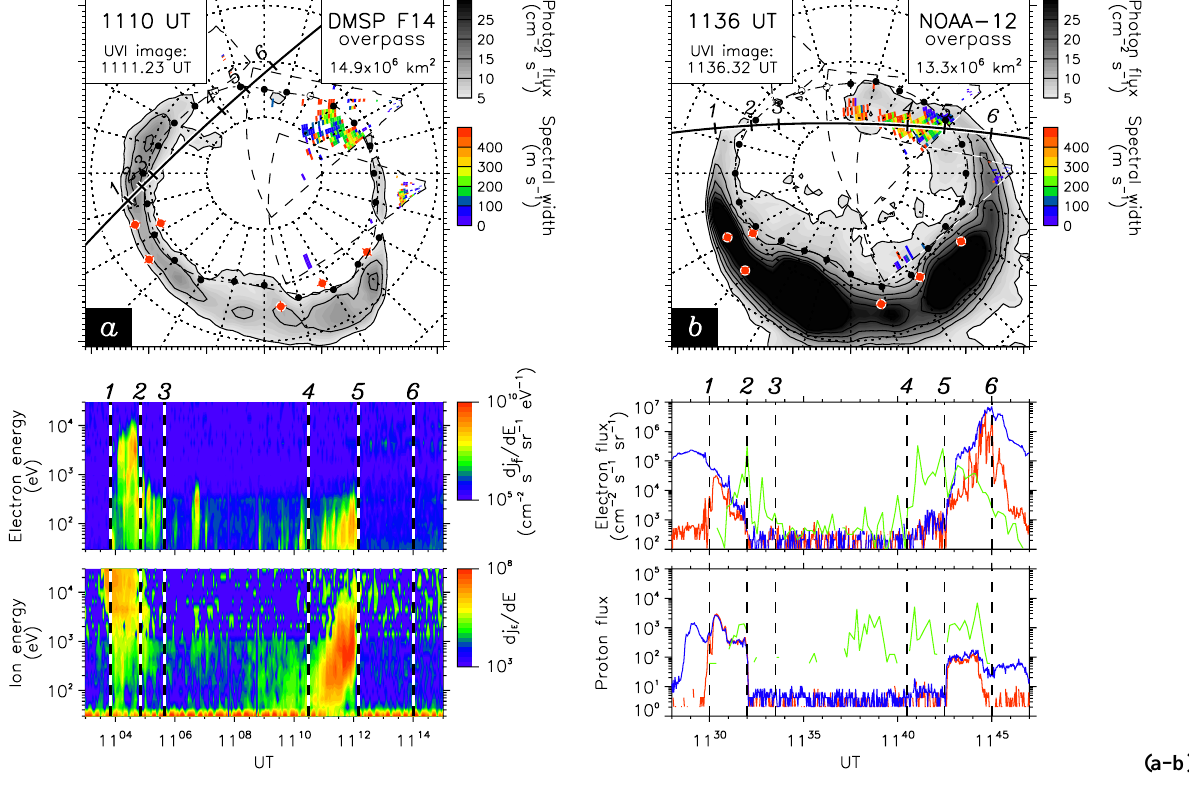
Fig. 4. (Upper panels) Composite plots of the Polar UVI auroral luminosity (grey scale) and radar spectral width (colour scale) on magnetic latitude and MLT coordinates. Dotted circles represent 60 ◦ , 70 ◦ , and 80 ◦ latitudes and radial dotted lines represent MLT meridians, 12 MLT being directed towards the top of the panel. Dashed lines show the fields-of-view of the radars. Filled dots indicate estimates of the OCB latitude at each MLT meridian, open dots showing interpolated points in regions where no observations are available. The dot-dashed line is a somewhat smoothed fit to these points (see text for details), i.e. indicates a rough estimate of the location of the OCB. Superimposed is the track of the overpassing spacecraft, tick marks indicating the locations of boundaries 1 − 6 identified in the lower panels. Red dots mark the locations of magnetometers employed in the study: from west to east, TIK, KTN, CHD, DAWS, FSIM, and RABB. (Lower panels) Electron and ion measurements from the overpassing satellite. In the case of DMSP F13 and F14 and FAST, these are spectrograms between ∼ 10eV and 30keV. In the case of NOAA-12 these are fluxes of > 30keV electrons and ions at two pitch angles – 10 ◦ (i.e. precipitating; red lines) and 80 ◦ (i.e. trapped; blue lines) – and ∼ 100eV particles mainly of magnetosheath origin (green lines). These latter fluxes have been reduced by a factor of 10 3 for plotting purposes. From these observations, six boundaries have been identified, 1 and 6 being the approximate equatorward boundary of precipitating trapped particles, 2 and 5 the poleward edge of this region, i.e. the trapping boundary, our proxy for the OCB, and 3 and 4 the approximate poleward edge of the magnetosheath